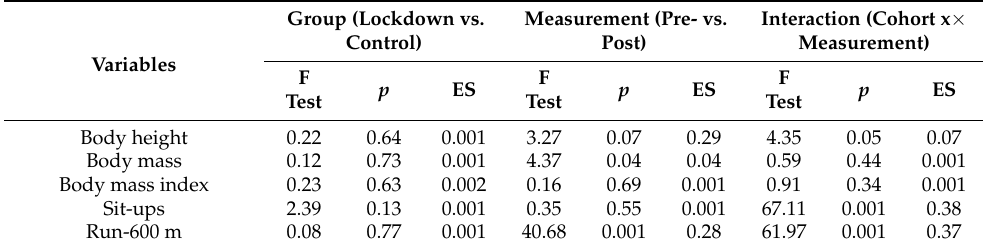
Table 1. Results of the repeated measurement factorial analysis of the variance with cohort (control vs. lockdown) as the group-factor, with F-test, p -level, and effect size (ES) reported. Group (Lockdown vs. Measurement (Pre- vs. Interaction (Cohort x × Control) Post) Variables